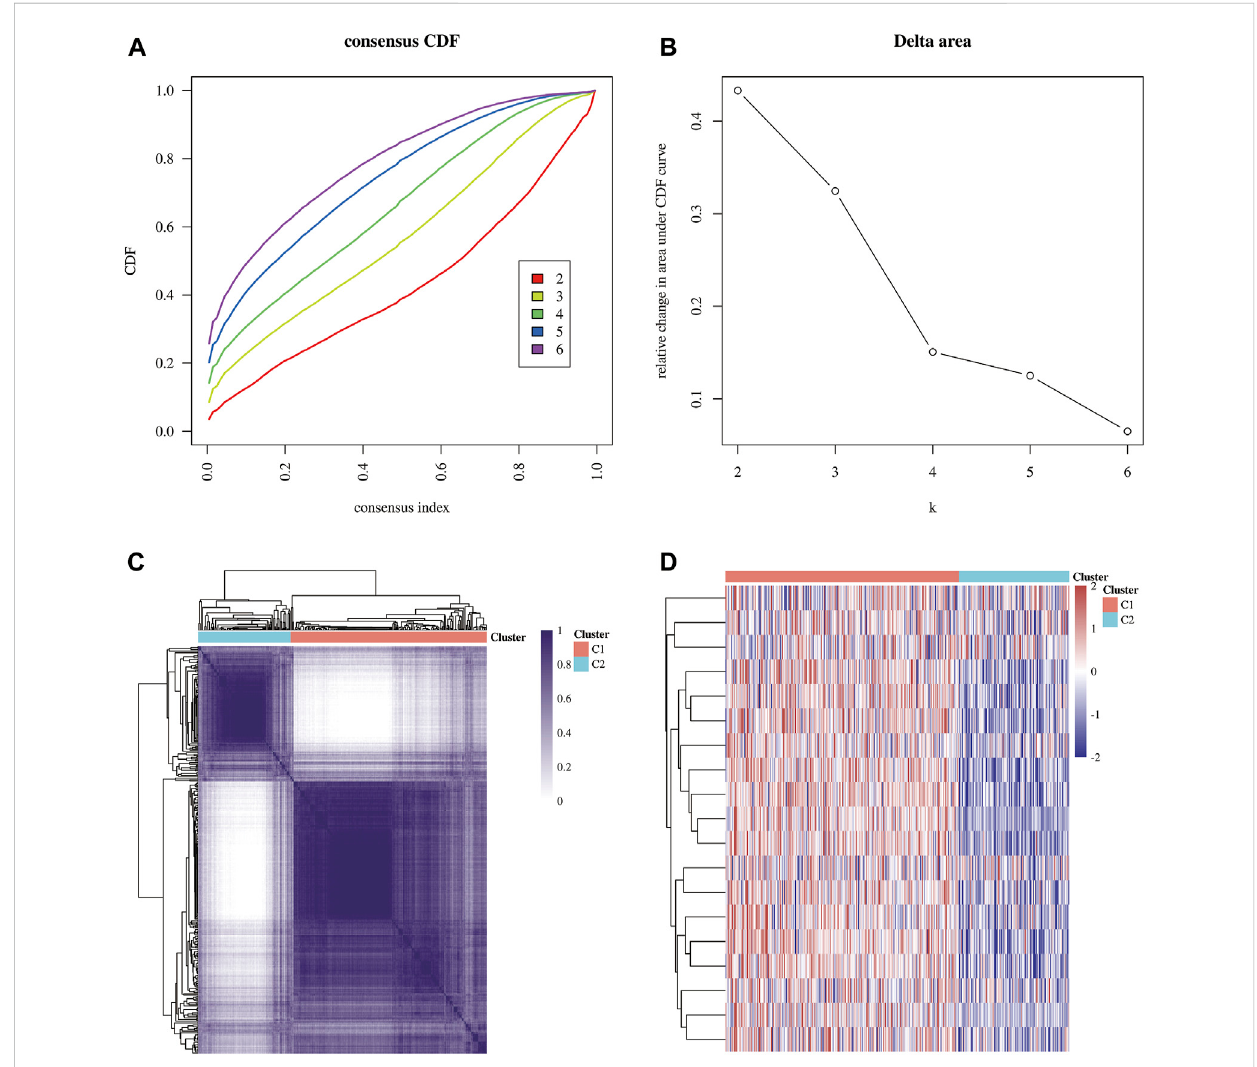
FIGURE 2 Identi fi cation of common clusters based on the expression of CRGs. (A) Cumulative distribution function (CDF) (k = 2 – 6). (B) Relative change of the areaunder theCDF curve(k= 2 – 6). (C) Consensusclustering matrix (k= 2). (D) Heatmap ofcuproptosis-related geneexpression indifferentsubgroups; red for high expression and blue for low